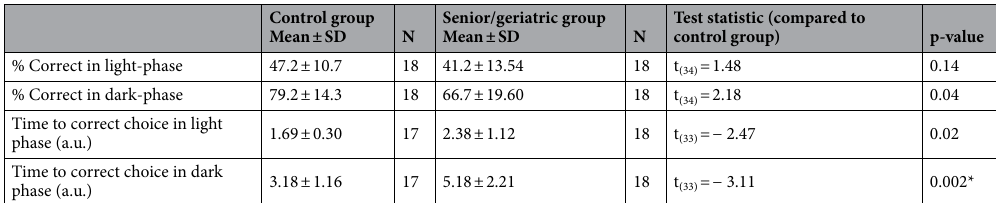
Table 2. Comparison between the control and senior/geriatric groups in both the light and dark-phase conditions. Comparisons to the control group are reported with t-statistic and relevant p-value. *Indicates a p-value of less than 0.013 (Bonferroni corrected p-value for 4 comparisons).